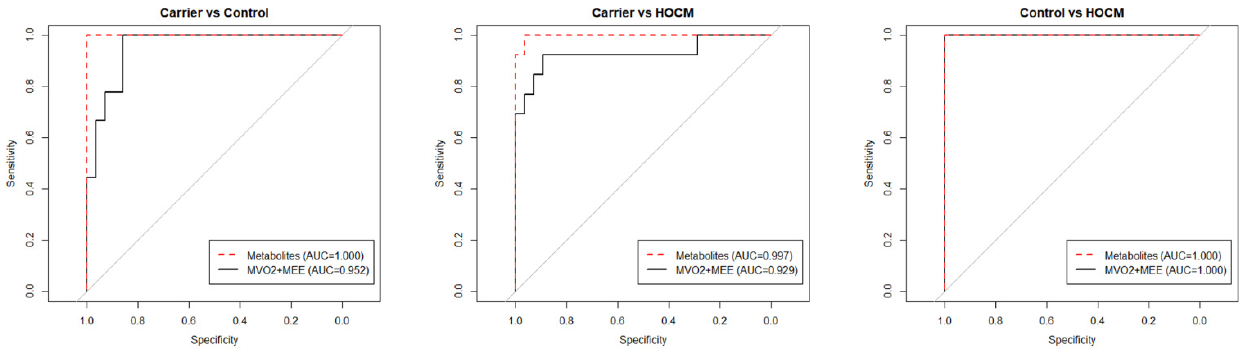
Figure 4. Sensitivity and specificity curves comparing the performances of the metabolomics data and the clinical imaging data in distinguishing the groups.